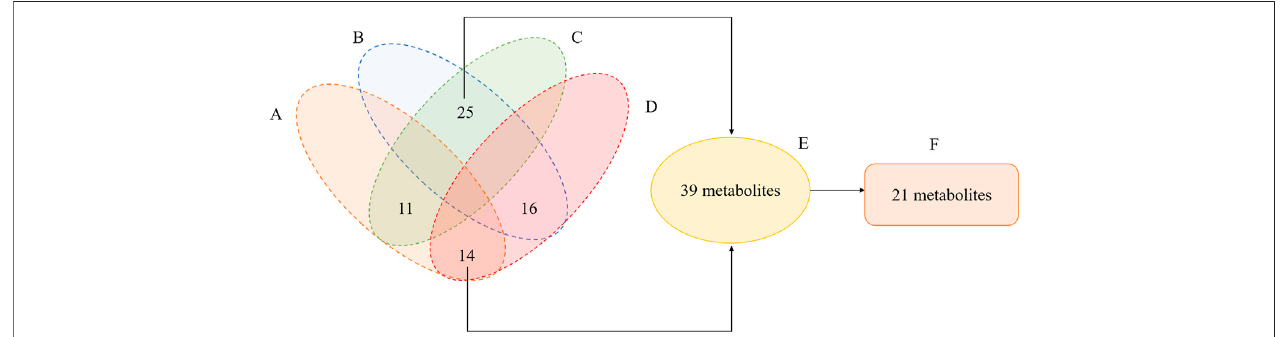
FIGURE 5 | Venn diagram illustrated the overlapping and unique differential metabolites among the comparison groups. (A) metabolites showed elevated levels in the M vs. C group. (B) metabolites showed decreased levels in M vs. C group. (C) metabolites showed elevated levels in the Q vs. M group. (D) metabolites showed decreased levels in Q vs. M group. (E) metabolites showed opposite variation trends between M vs. C and Q vs. M. (F) metabolites had a close expression level in Q vs. C